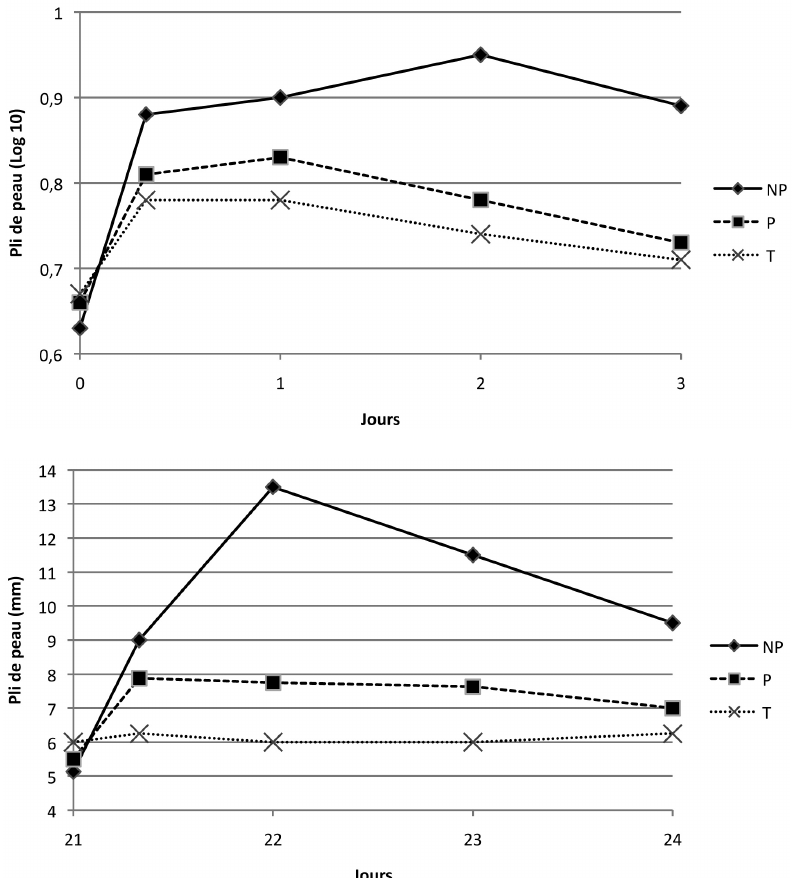
Figure 5. – Moyenne des mesures de plis de peau (transformées en